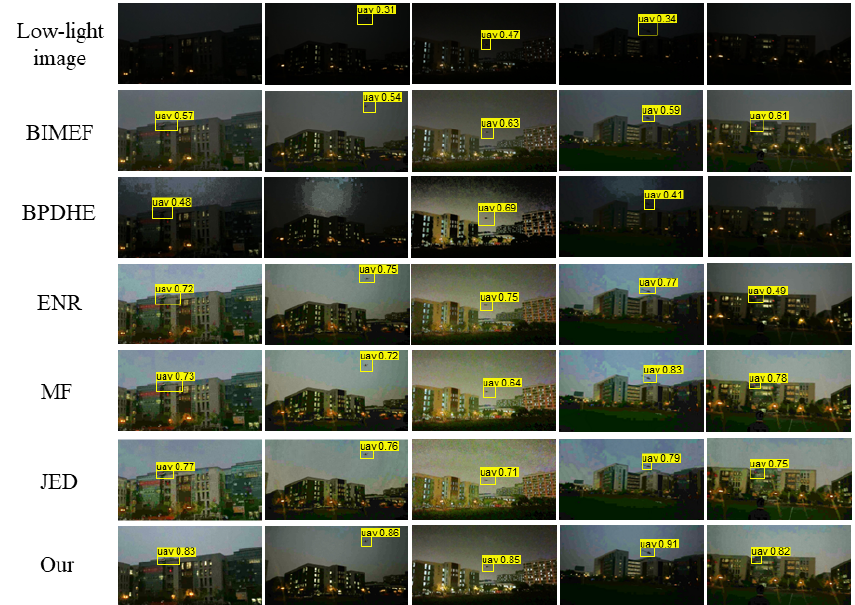
Figure 15. Obstacle detection results of the images enhanced by different algorithms. The first row is the detection results of the original low-light image, rows 2–7 are the detection results of the BIMEF, BPDHE, ENR, MF, JED, and the proposed algorithm-enhanced images,